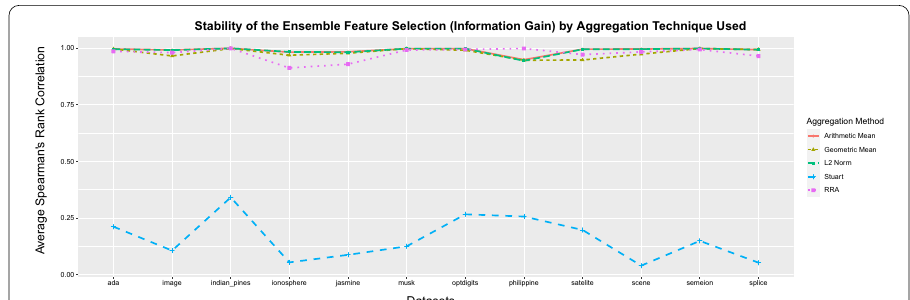
Fig. 17 Stability Analysis using Spearman’s Rank Correlation Coefficient (IG)